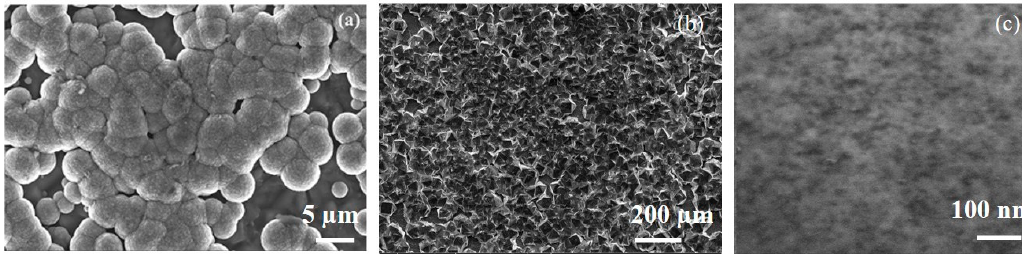
Figure 2. Scanning electron microscope images of diamond film after growth, ( a ) nitrogen diamond film, ( b ) poly-crystalline diamond, ( c ) single crystalline diamond film.